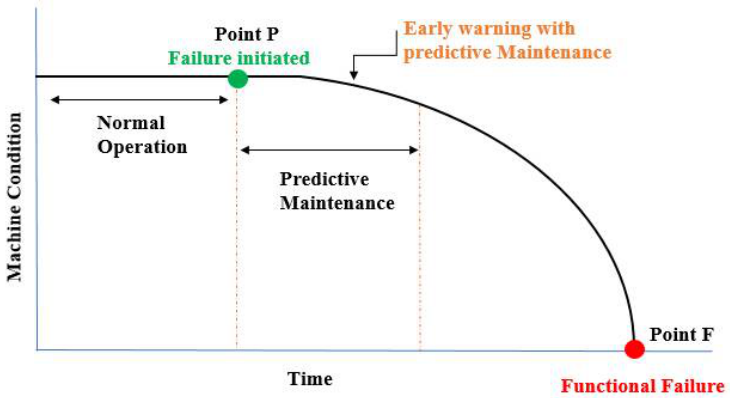
Figure 4. Potential failure diagram presenting inspection intervals and predictive maintenance.